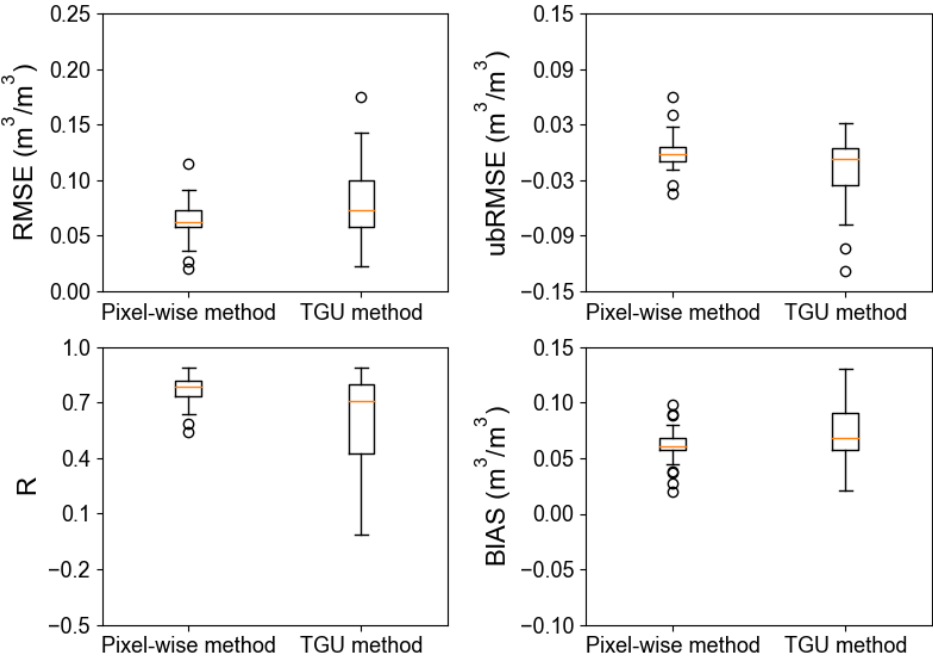
Figure 12. Boxplots of the gap-filled surface soil moisture by the traditional global uniform (TGU) gap-filling method and our pixel-wise method in ten sub-regions compared with the original NN SM values.